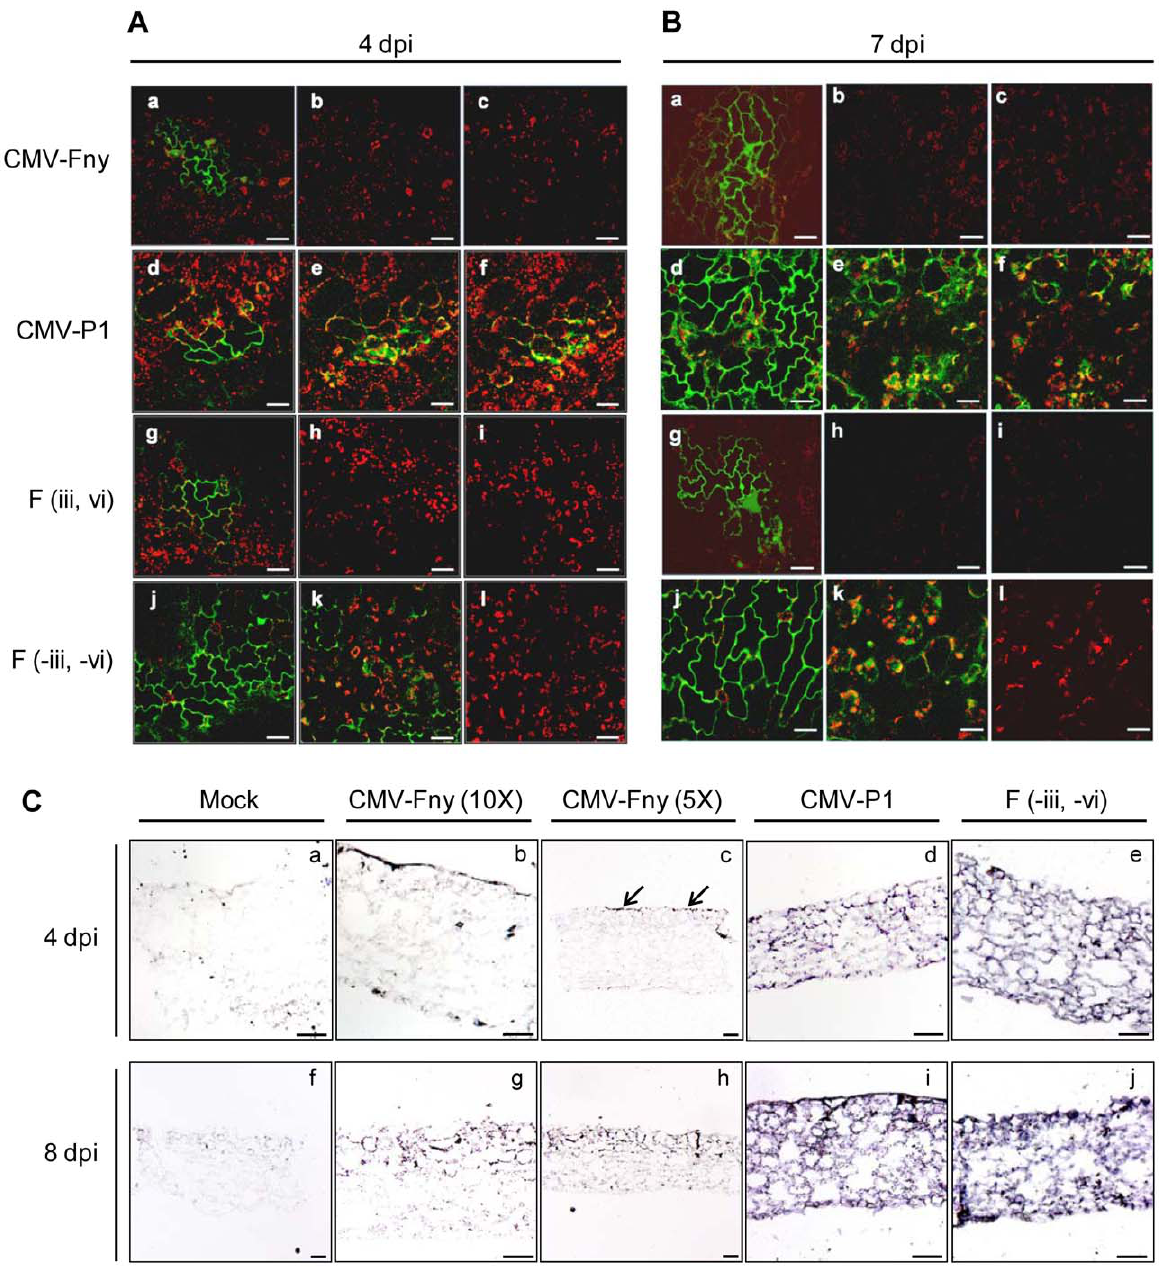
Figure 5. Virus movement and localization studies with CMV clones. A and B , Localization of CMV-Fny-GFP (A–a, b, c; B–a, b, c), CMV-P1- GFP (A–d, e, f; B–d, e, f), F (iii, vi)-GFP (A–g, h, i; B–g, h, i), and F (-iii, -vi)-GFP (A–j, k, l; B–j, k, l) in C. annuum ‘Bukang.’ Images a to c, d to f, g to i, and j to l in panels A and B indicate optical sections moving down into the leaf from the epidermal cells at the leaf surface to the underlying mesophyll cells. GFP fluorescence was visualized by confocal laser scanning microscopy at 4 (A) and 7 (B) days post-inoculation (dpi). Green indicates GFP fluorescence and red indicates chlorophyll autofluorescence. Scale bars=50 m m. C , In situ hybridization localization of the CMV-Fny, P1 and F (-iii, -iv) in inoculated leaves of C. annuum ‘Bukang’ at 4 dpi (C–a to e) and 8 dpi (C–f to j). These images are transverse sections of mock (a and f)-, CMV-Fny (b, c, g and h)-, CMV-P1 (d and i)- and F (-iii, -iv) (e and j)-inoculated leaf tissues. The sections of CMV-Fny inoculated leaves shows two scale images, 10X (b and g) and 5X (c and h). Purple color and arrows indicate the infected region. Scale bars=100 m